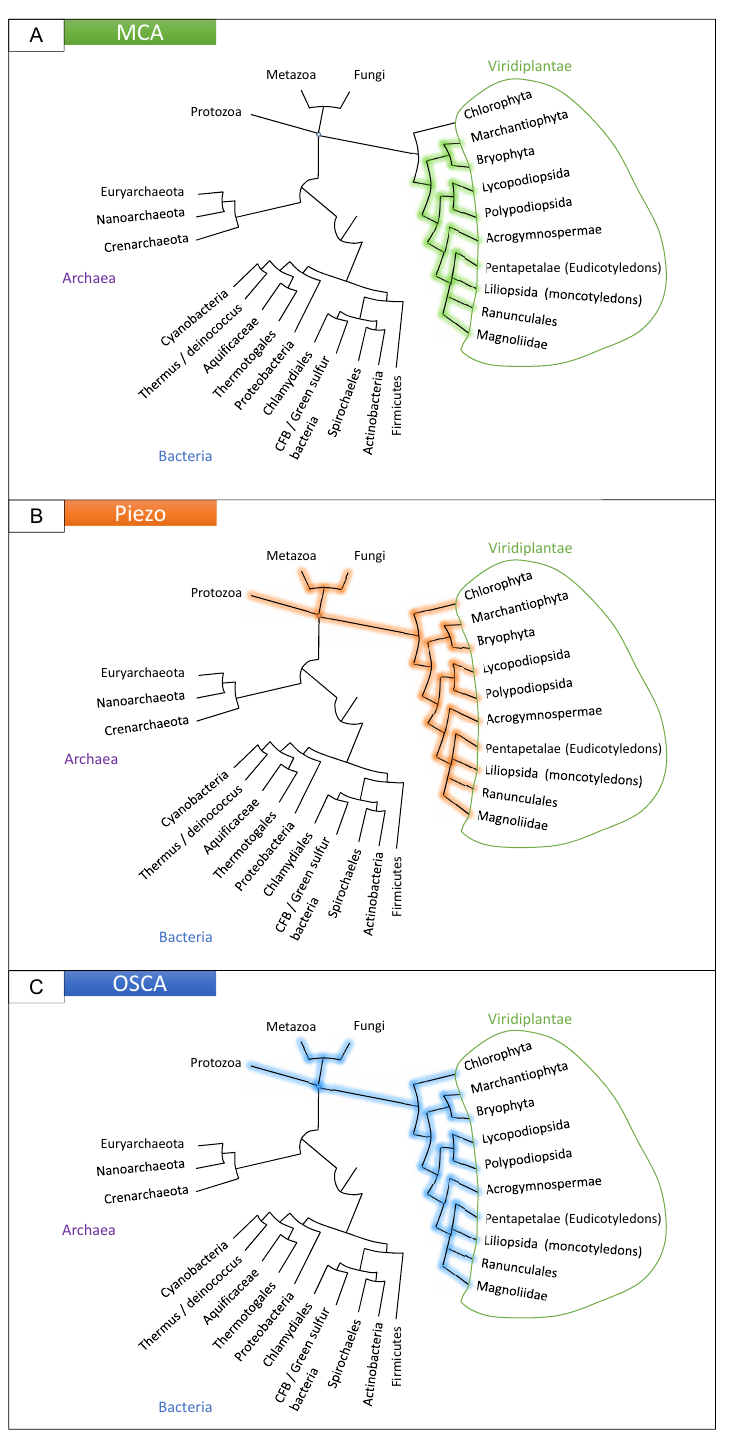
Figure 2. Presence of the MCA ( A ), Piezo ( B ) and OSCA ( C ) families in the tree of life. See Appendix A for